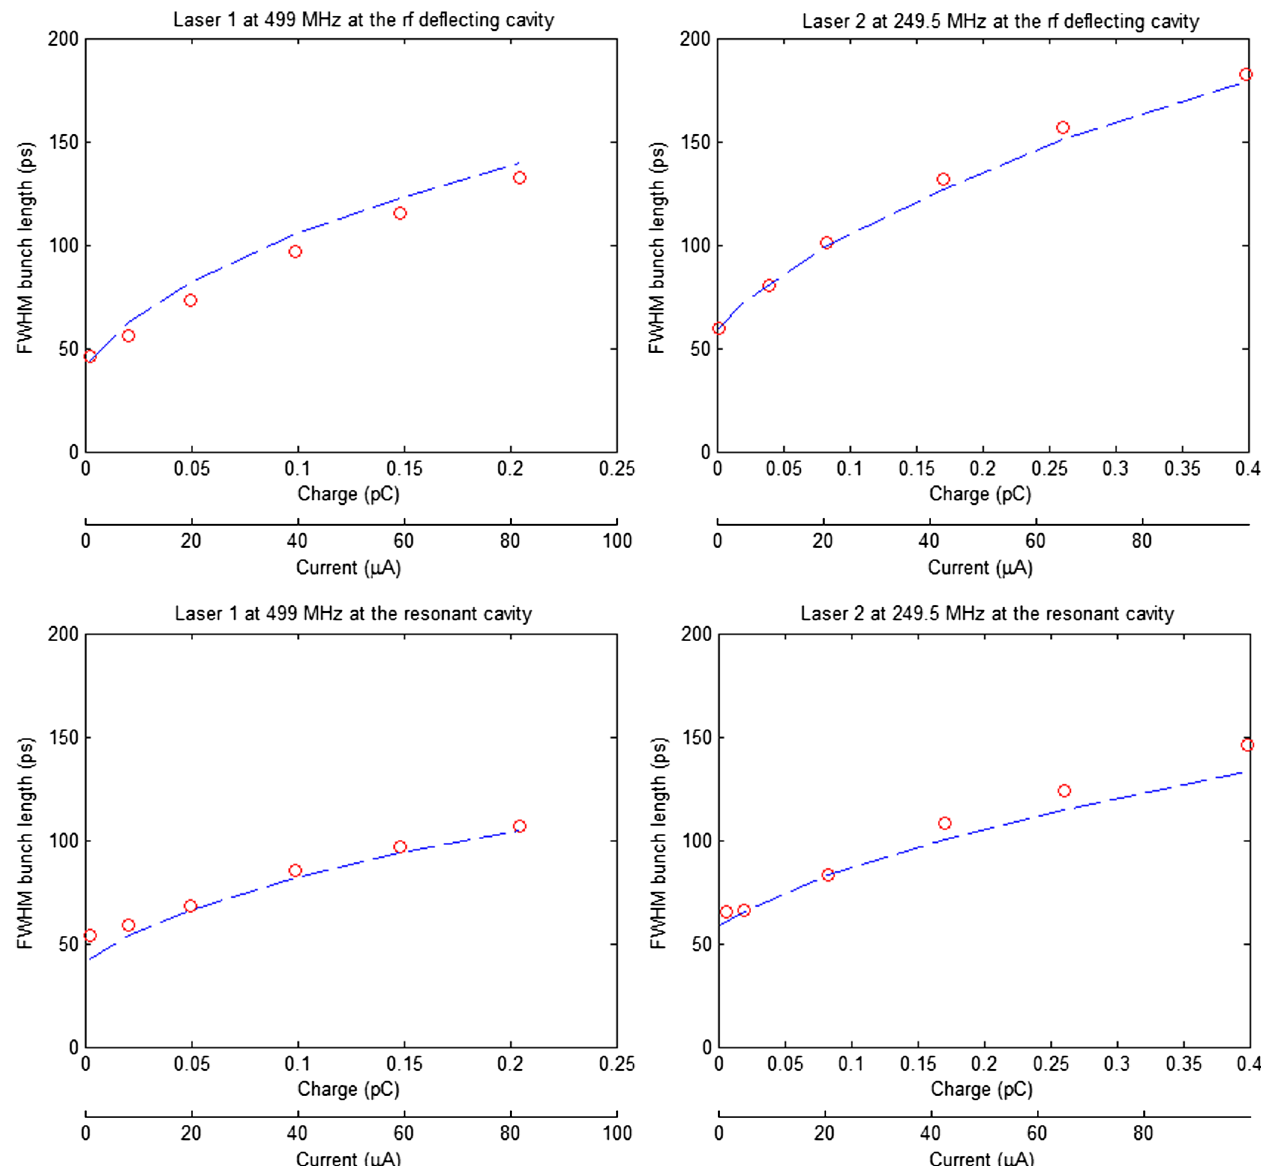
FIG. 7. Electron bunch-length as a function of bunch charge (average current varied from 1 to 100 μ A) with measurements obtained using the invasive RF-deflecting cavity technique (top) and the harmonically resonant cavity (bottom), together with simulation results using the particle tracking code ASTRA. Left) measurements made using “ laser 1 ” at 499 MHz and, Right) measurements made using “ laser 2 ” at 249.5